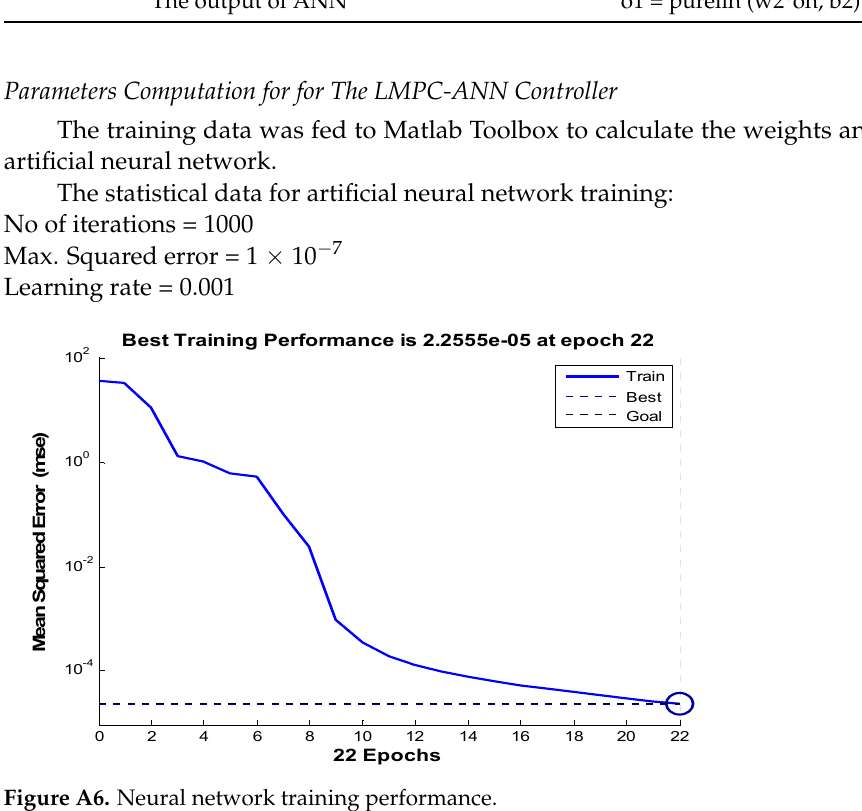
Figure A6. Neural network training performance.